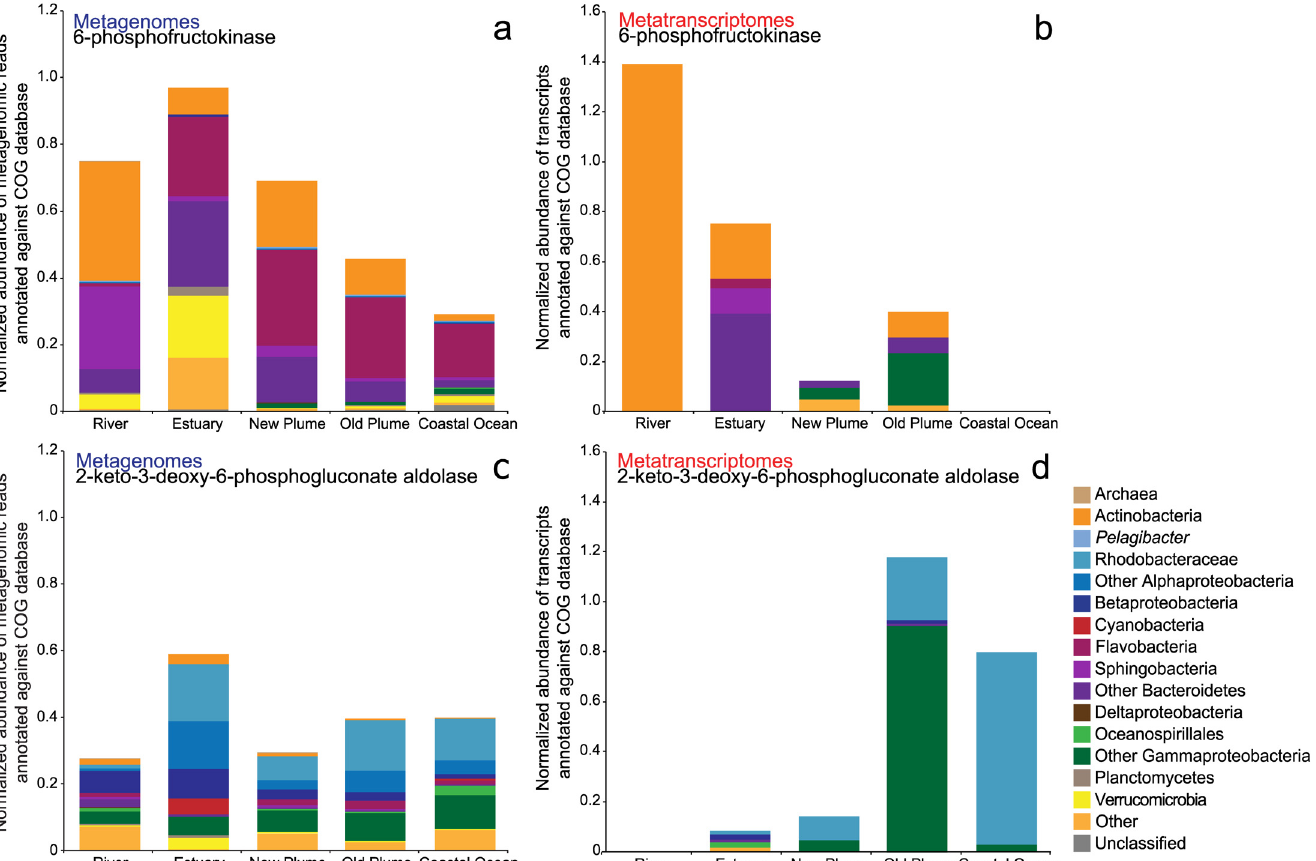
Fig 6. Gene abundance and expression for key indicator enzymes associated with glycolysis. Abundance (a) and expression (b) of the key enzyme in the Embden-Meyerhof (EMP) pathway, 6-phosphofructokinase, represented by COG205. Abundance (c) and expression (d) of the key enzyme in the pathway Entner-Doudoroff (ED) pathway, 2-keto-3-deoxy-6-phosphogluconate aldolase, represented by